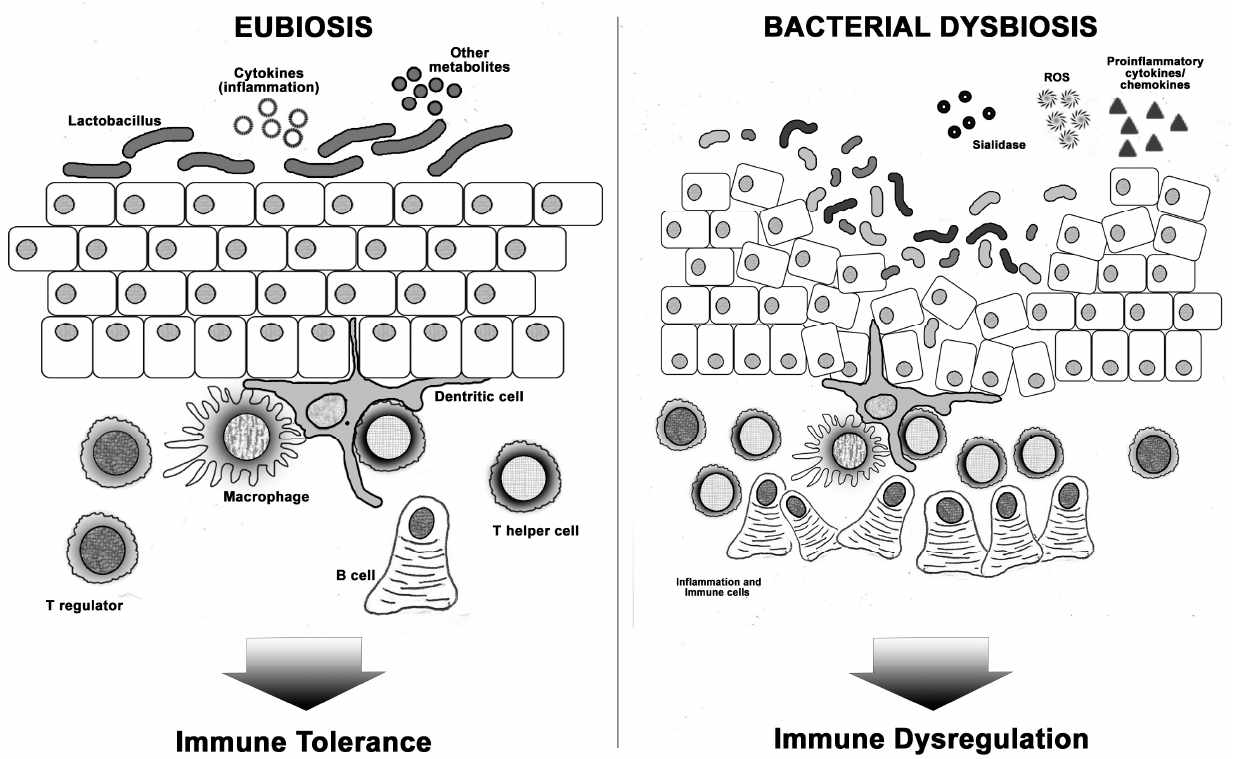
Figure 1. Microbiome and immune system regulation: microbial homeostasis promotes barrier integrity. Bacterial dysbiosis induces mucosal barrier alterations with the release of inflammatory mediators and activation of immune cells.